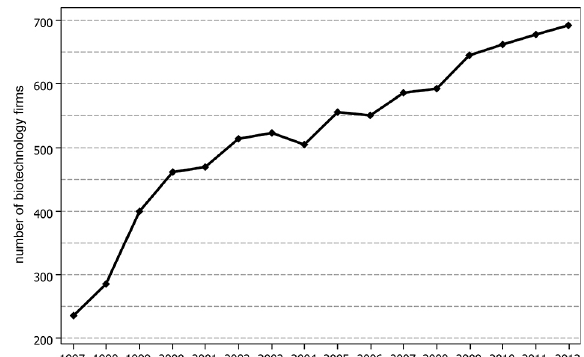
Fig. 4. Number of biotech companies in Germany, 1997– 2012 Source: own calculations based on Dohse (2000) and the Internet portal